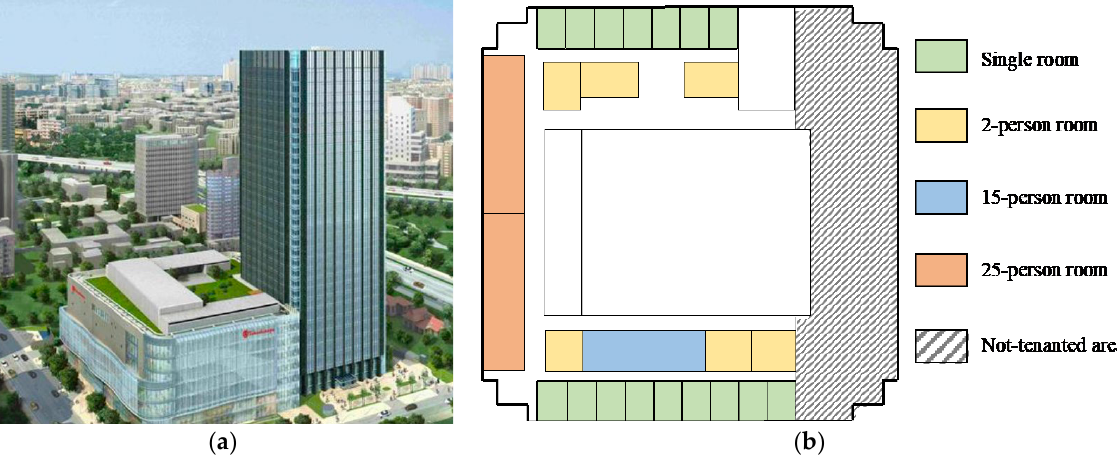
Figure 5. ( a ) Study building and ( b ) building layout of one